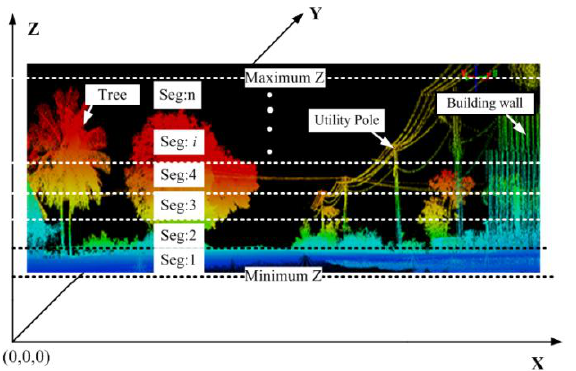
Figure 1. Vertical segmentation of MLS data